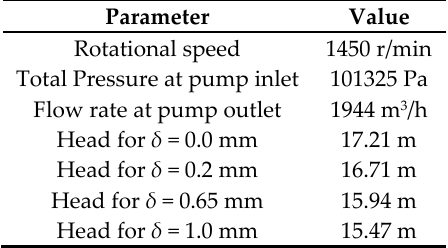
Table 3. Flow conditions for transient